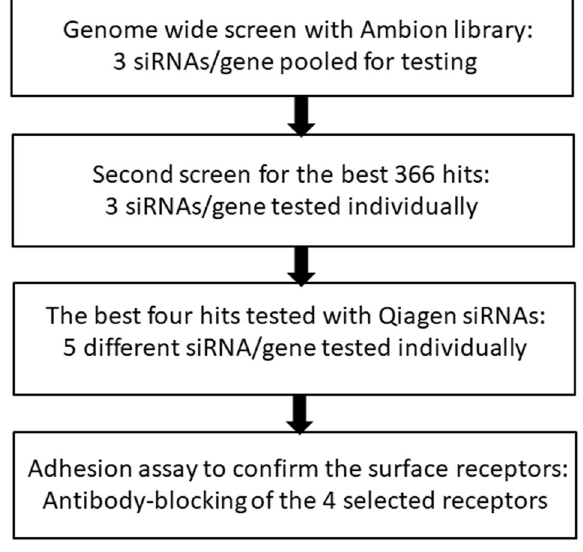
Fig. 2 Work fl ow of a high-throughput siRNA silencing assay. The assay was used to screen proteins that might serve as host surface receptors for bacterial binding and uncovered four receptors for the commensal B. bi fi